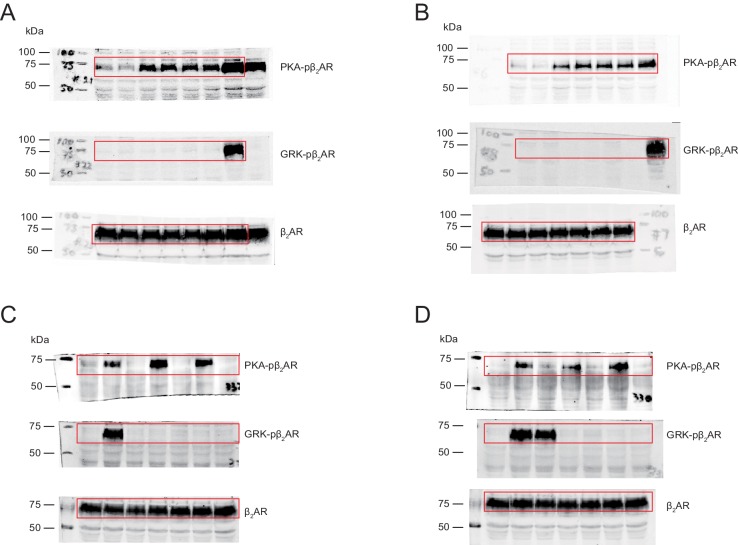
Uncropped blots for Figure 2.(A) Uncropped blots corresponding to Figure 2A. (B) Uncropped blots corresponding to Figure 2B. (C) Uncropped blots corresponding to Figure 2C. (D) Uncropped blots corresponding to Figure 2D. Red box indicates the crop region displayed in main figure.